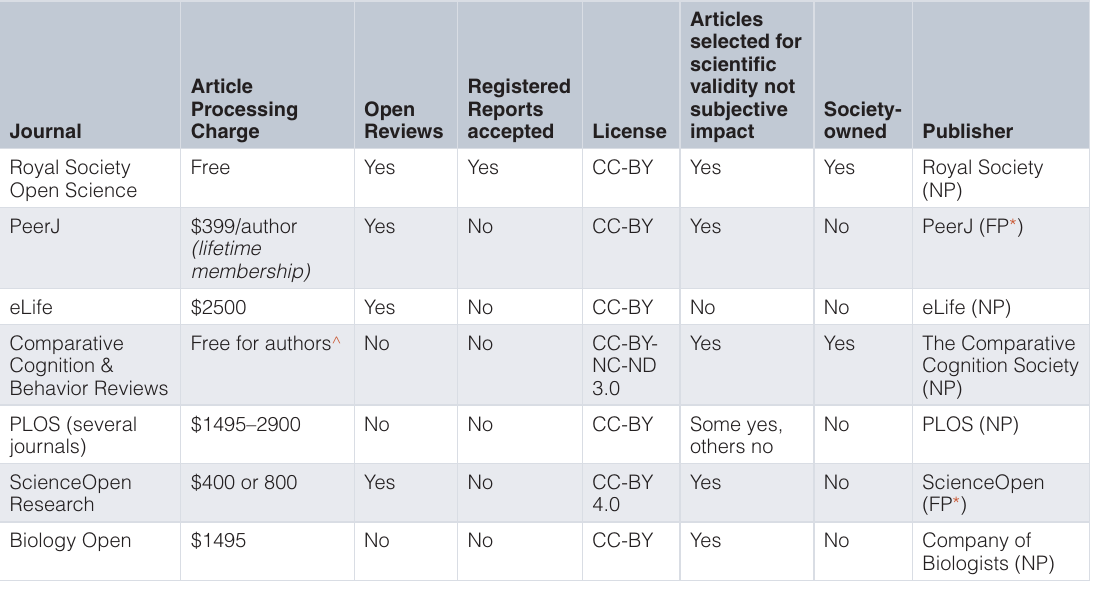
Table 1. Examples of ethical publication options from the field of animal behavior. 100% open access journals (listed in the Directory of Open Access Journals; www.doaj.org) at publishers that keep profits inside academia. Article processing charges vary from $0–2900 and fit a range of budgets. In addition to making articles open access, other factors that can promote research rigor include publishing the review history alongside the published article (Open Reviews), having the methods and analyses peer-reviewed before the data are collected (Registered Reports), and selecting articles based on their scientific validity rather than their predicted impact on the field (which is subjective). CC-BY licenses allow people to not only read the article, but also to access its content. Some researchers prefer to submit papers to society-owned journals. NP=non-profit organization, FP=for-profit